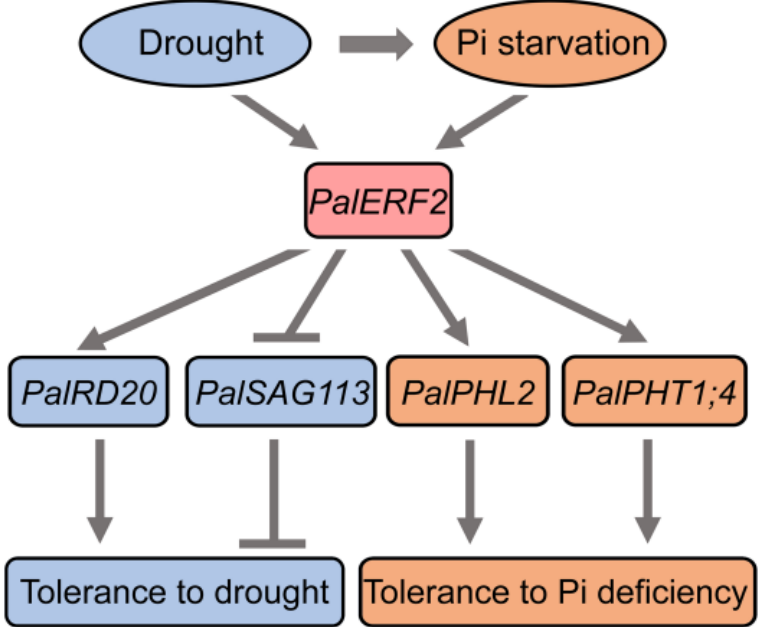
Figure 7. The proposed model for the PalERF2 mediated drought stress and low Pi responses in poplars.